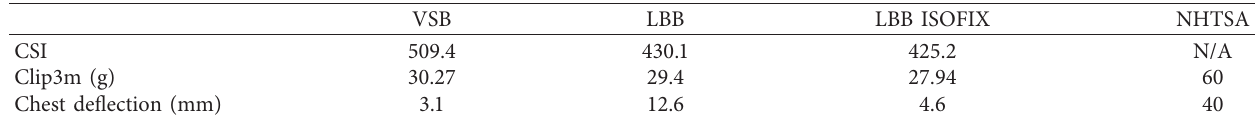
Figure 9: Thoracic deflection. Table 3: Thoracic injury